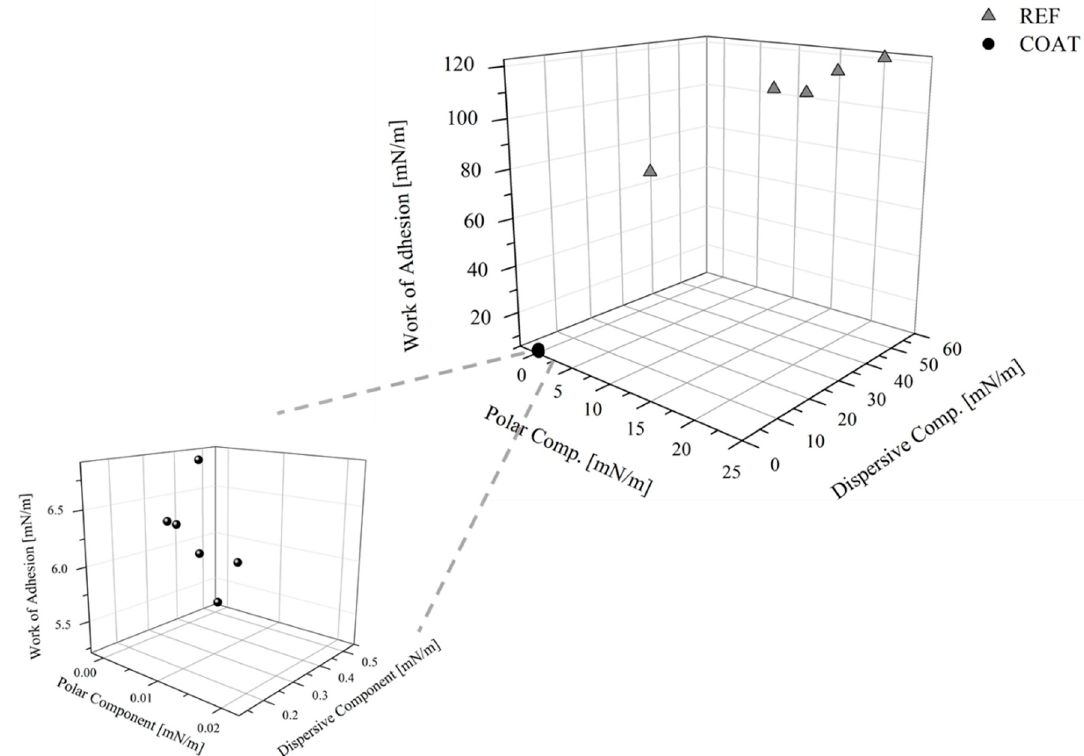
Figure 13. Polar and dispersive components of the SFE and the W A for the references and the coated